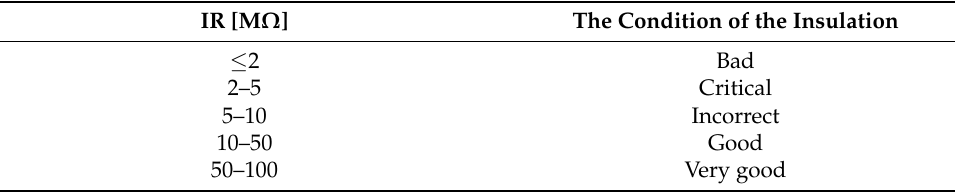
Table 2. Influence of the IR insulation resistance on the condition of the insulation system.